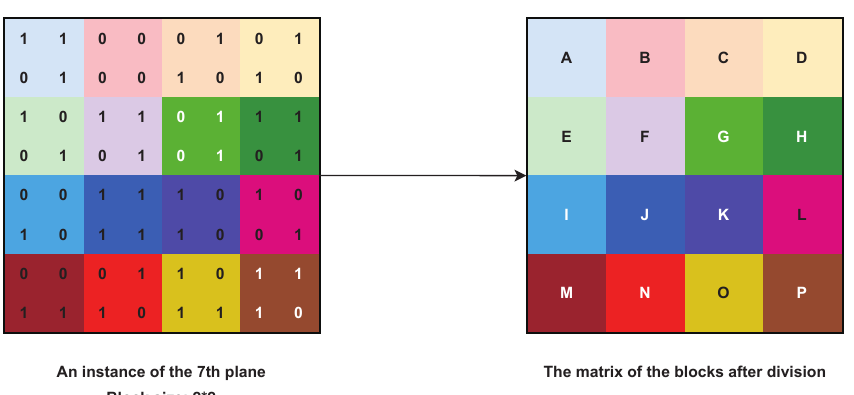
Figure 6. An instance of division for the plane where the blocks after division are named from A to P.